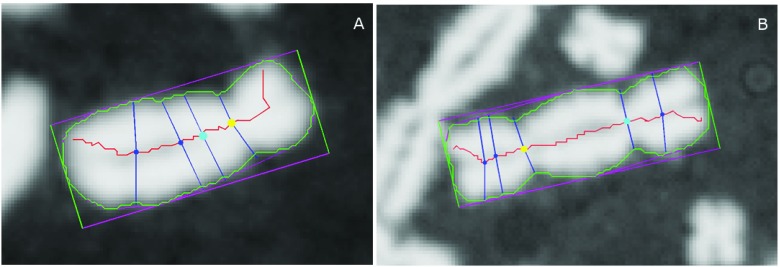
Chromosome images processed by ADCI, annotated with key segmentation features.(
A) Monocentric and (
B) Dicentric chromosome. Chromosome contour overlaid in green, long-axis centreline in red. For reference, the minimum bounding box of the contour is also displayed in magenta and green. Yellow and cyan markers on the centerline indicate the top-ranked and 2
nd-ranked centromere candidates, respectively, and all other candidates are indicated with a dark blue marker. For each centromere candidate, their corresponding width traceline (crossing through the candidate and running approximately orthogonal to the centerline) are displayed in dark blue. The arc lengths of width tracelines running down the centerline (not all shown) are used to construct a chromosomal width profile. Note that for the monocentric chromosome (
A), the top-ranked candidate correctly labels the true centromere location, while the 2
nd-ranked candidate labels a minor non-centromeric constriction. Meanwhile, for the dicentric example (
B), both the top and 2
nd-ranked candidates label true centromere locations. By comparing features extracted from the top 2 candidates (including width and pixel intensity information), the software will determine if the chromosome is monocentric or dicentric.